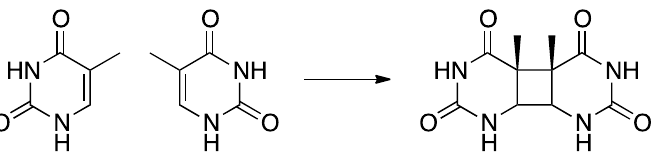
Figure 6. Two adjacent thymine residues forming a thymine dimer via a cycloaddition reaction.